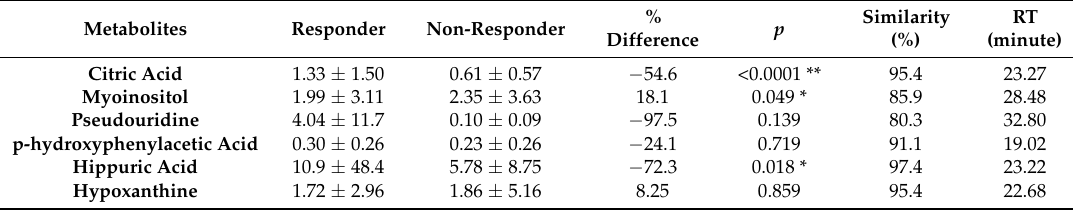
Figure 2. Receiver operating characteristic (ROC) curve illustrating the diagnostic potential of significant metabolites. The ROC curve of citric acid relative intensity before metformin administration is plotted. The area under the ROC curve was 0.719 ( p < 0.0001). Table 2. Different relative intensity levels in responder and non-responder groups at baseline.